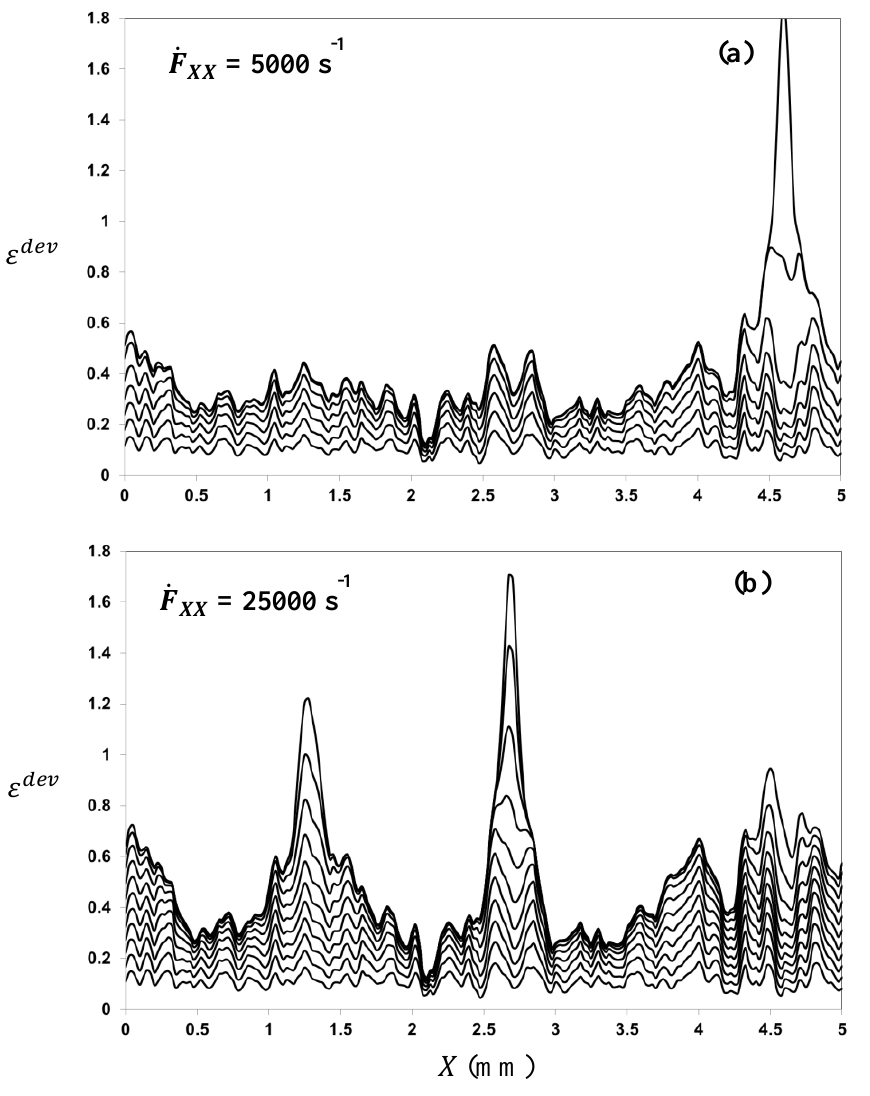
Fig. 5. Strain profile for the 50000 grain aggregate on the 𝑋 -axis (a) at times 𝑡 = 20 µs, 40 µs, 60 µs, 80 µs and 90 µs for stretching rate 𝐹̇ 𝑋𝑋 = 5000 s -1 and (a) at times 𝑡 = 4 µs, 8 µs, 12 µs, 16 µs, 20 µs and 24 µs for stretching rate 𝐹̇ 𝑋𝑋 = 25000 s -1